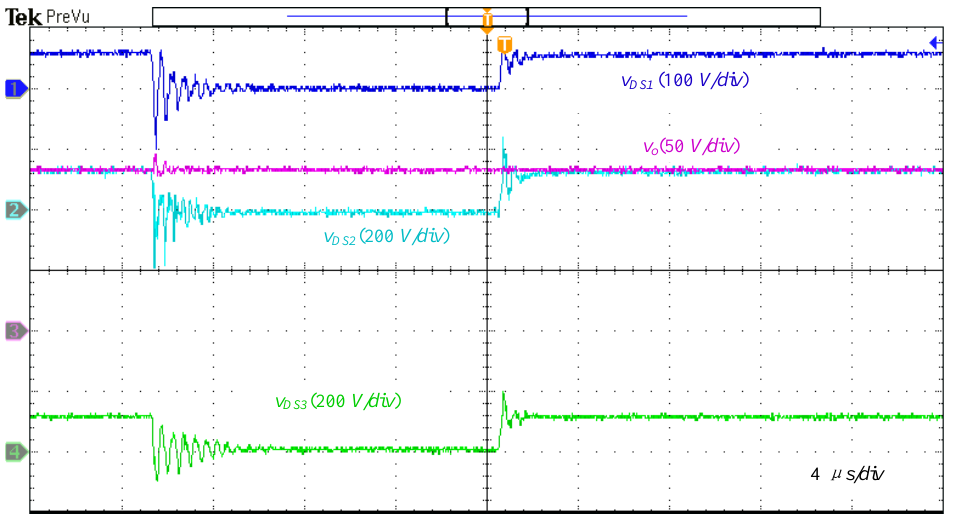
Figure 12. The output voltage, switch S 1 drain source voltage, S 2 drain source voltage, and S 3 drain source voltage at an input voltage 20 V and a duty cycle of 0.4. The circuit diodes D 1 and D o operate as a freewheeling diodes, and both are on when the switches are off. The diode D 1 reverse voltage is illustrated in Figure 13. Figure 13 shows a new case study, where the duty cycle is set to 0.6 with 20 V input voltage, and the output voltage is around 200 V. The inductor L 1 current is illustrated in Figure